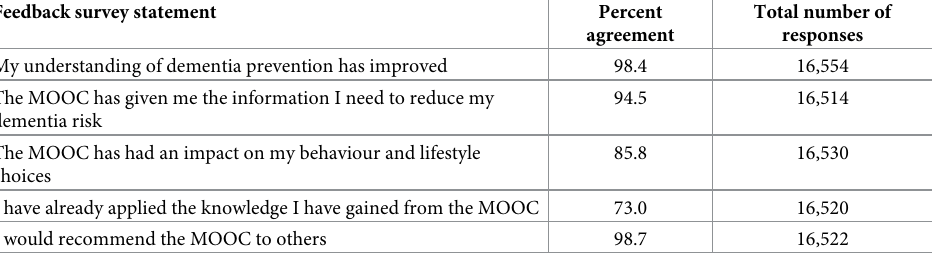
Table 3. Percentages of participants who agreed or strongly agreed with statements about possible outcomes from undertaking the Preventing Dementia MOOC across the seven course